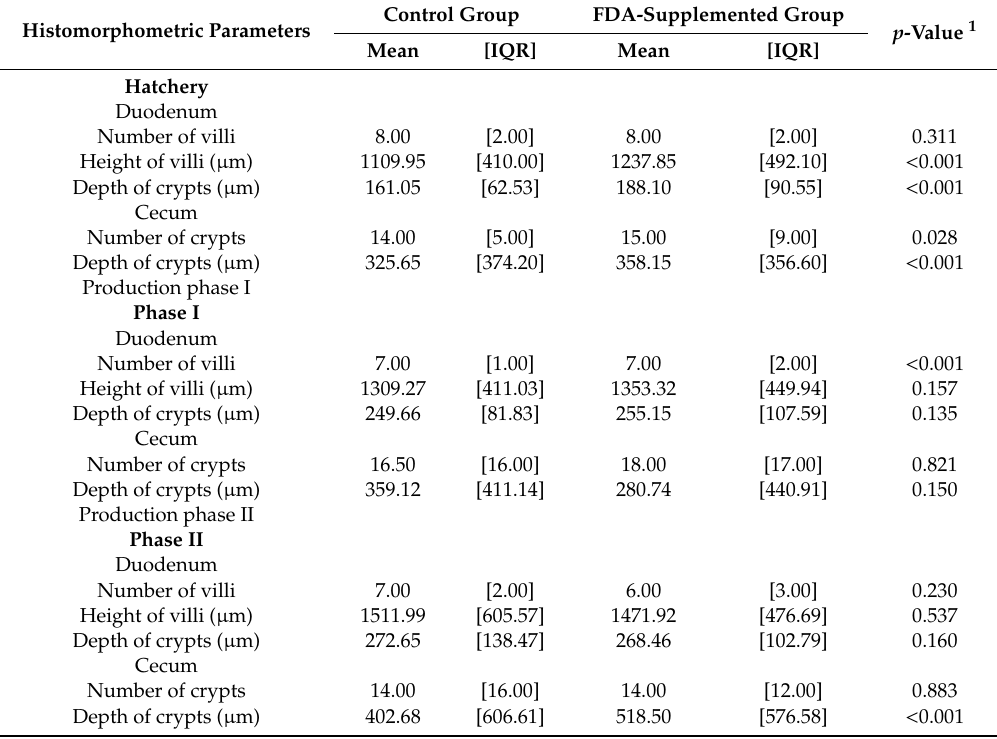
Table 1. Statistical results as mean and interquartile range (IQR) for villi number and height and crypt depth in the duodenum and crypt number and depth in the cecum in control and fermented defatted alperujo (FDA)-supplemented hens at three phases of production.